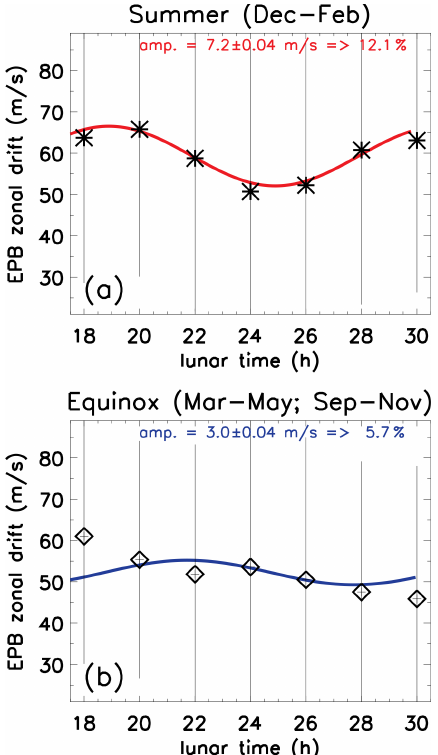
Figure 2. EPB zonal drift (stars) for the summer (stars in panel a ) and equinox (open diamonds in panel b ) obtained from airglow im- ages and semidiurnal lunar tide fit (red line in panel a and blue line in panel b ) as a function of lunar time. Error bars represent the stan- dard deviation at each hourly bin. The estimated amplitude and its uncertainty for a 12h oscillation are shown at the top of each